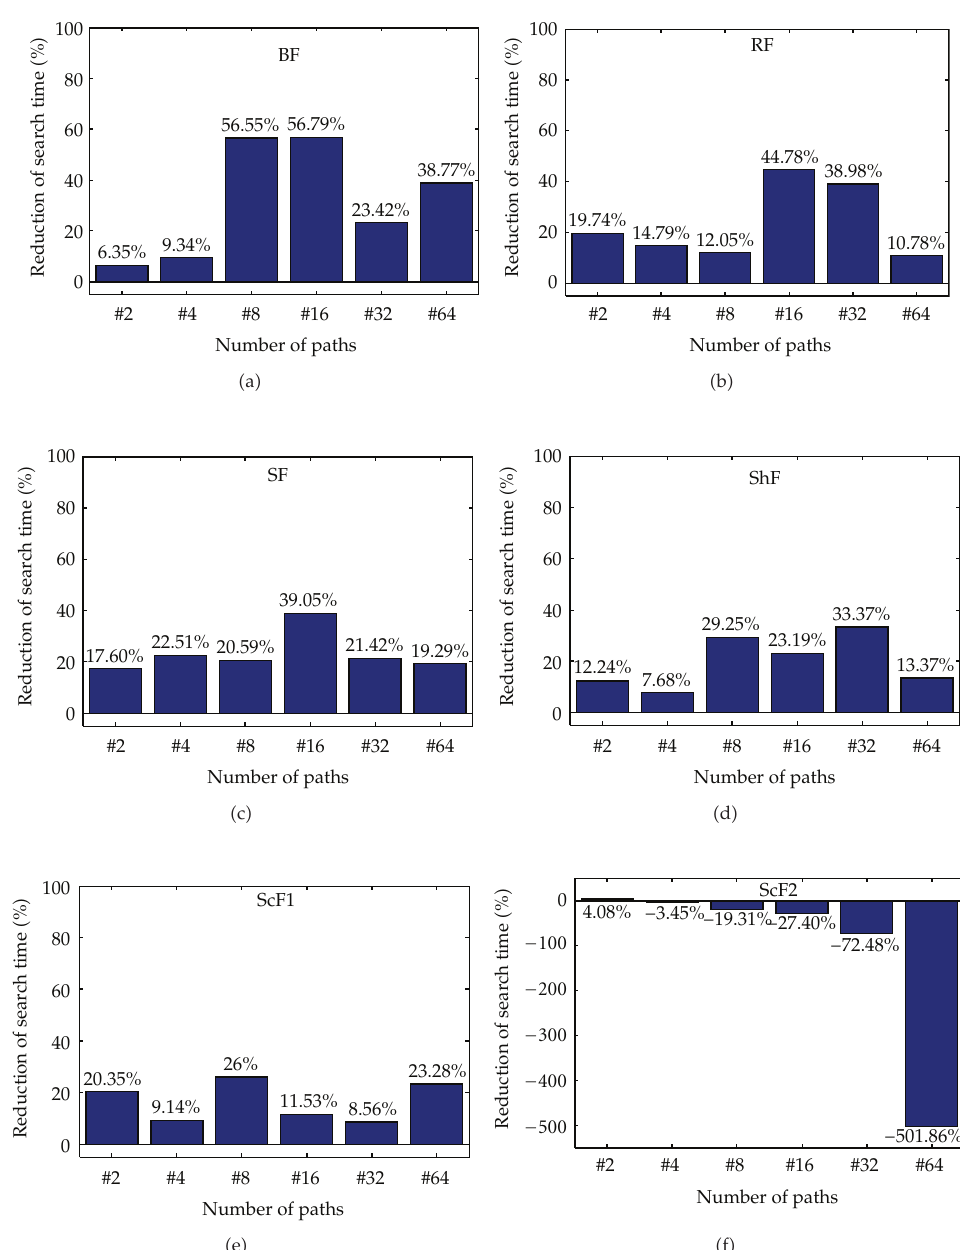
Figure 9: Bar graphs of the reduction of search time in